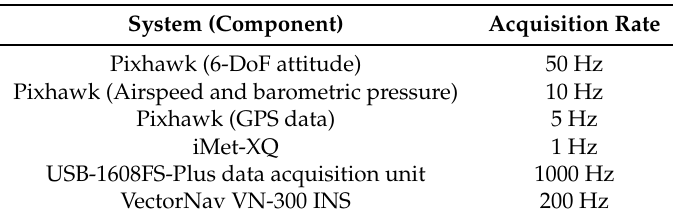
Table 2. Acquisition rates for on-board instrumentation